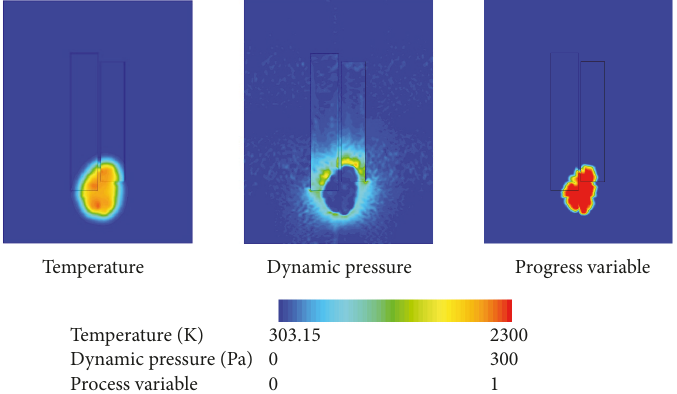
Figure 11: Overpressure effect of deflagration ( 𝜑 = 1.1 , t =